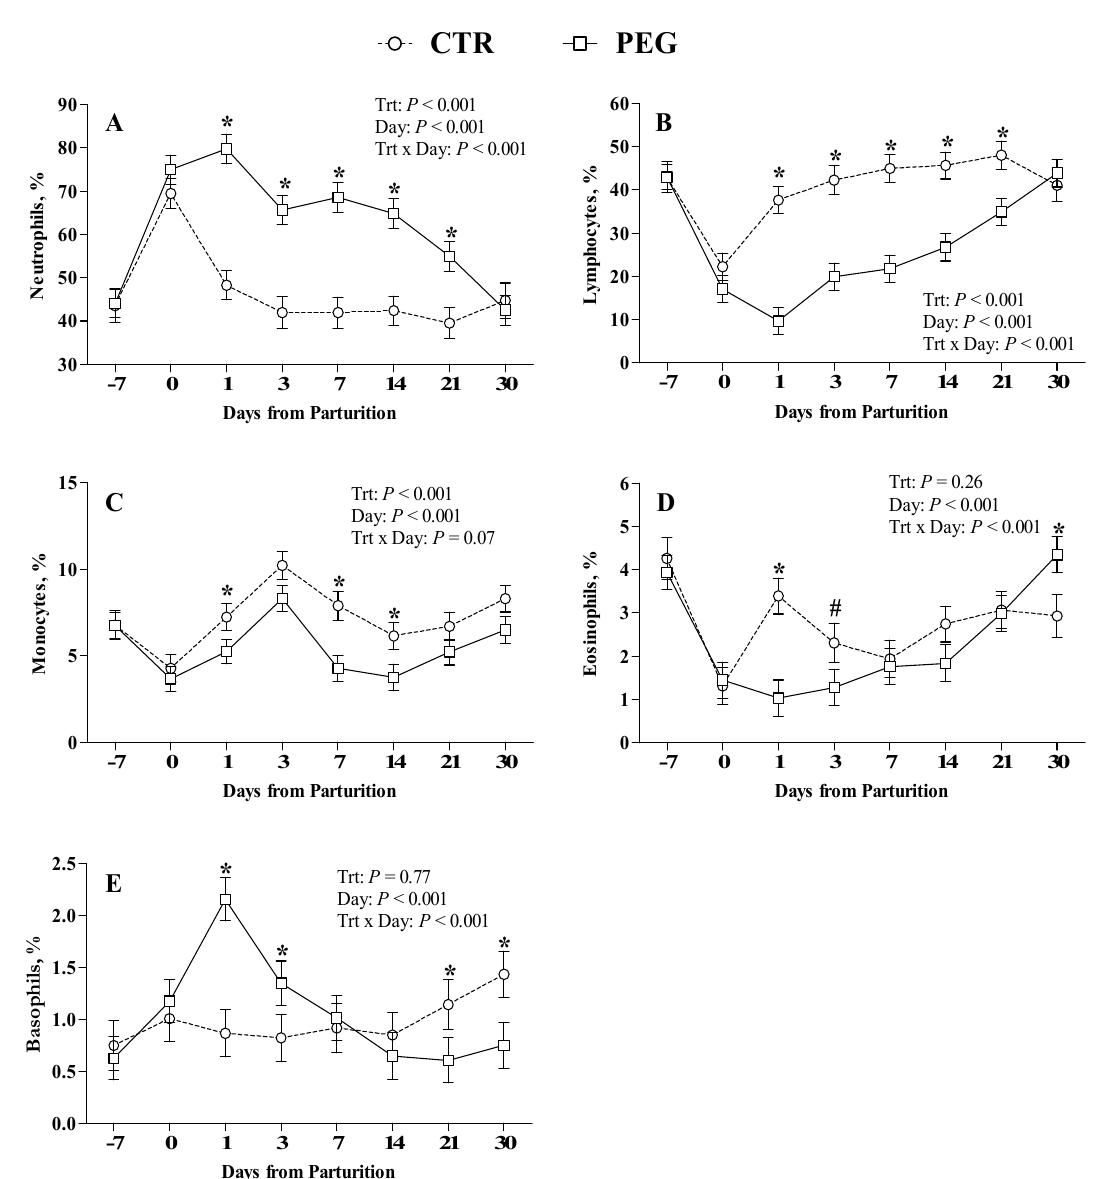
Figure 2. E ff ect of Pegbovigrastim on di ff erential WBC count. Least-squares means ± standard error of neutrophils ( A ), lymphocytes ( B ), monocytes ( C ), basophils ( D ), and eosinophils ( E ) percentage during the transition period of Simmental cows treated either with 2 subcutaneous injections of pegbovigrastim (PEG) or saline solution (CTR) at − 7 days relative to calving and within 6 h after calving. Asterisks (*) indicate di ff erences at p < 0.05, whereas hashtags (#) indicate tendency at 0.10 ≥ p > 0.05.